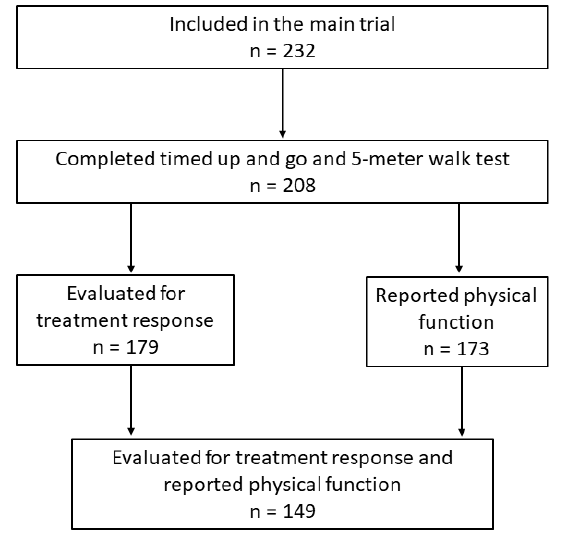
Figure 1. Patient selection.